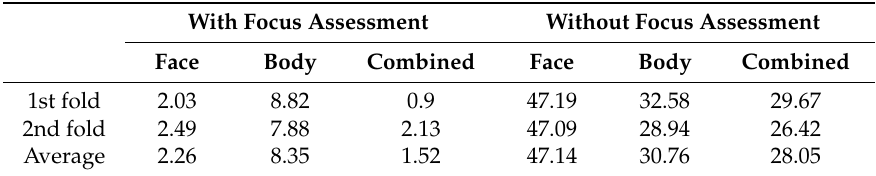
Table 11. Comparisons of EERs with and without focus assessment (unit: %).